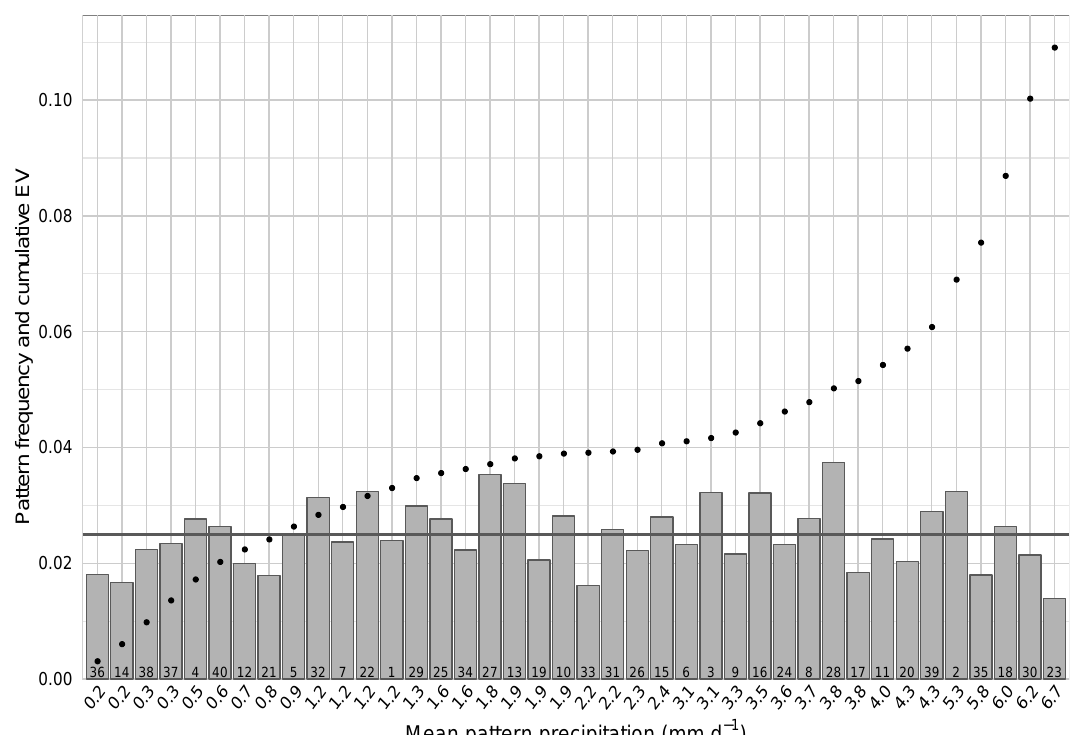
Figure 7. Precipitation intensity of patterns in relation to pattern frequency (bars) and cumulated explained variation per pattern (dots). The pattern number is given at the bottom of the bars. The grey horizontal line denotes the average frequency to aid distinction of rare and frequent